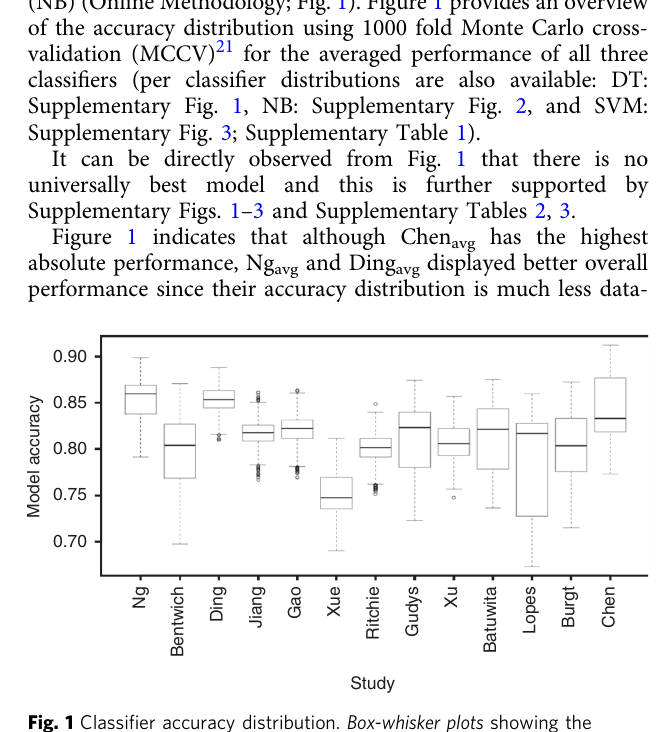
Supplementary Fig. 1, NB: Supplementary Fig. 2, and SVM: Supplementary Fig. 3; Supplementary Table 1).